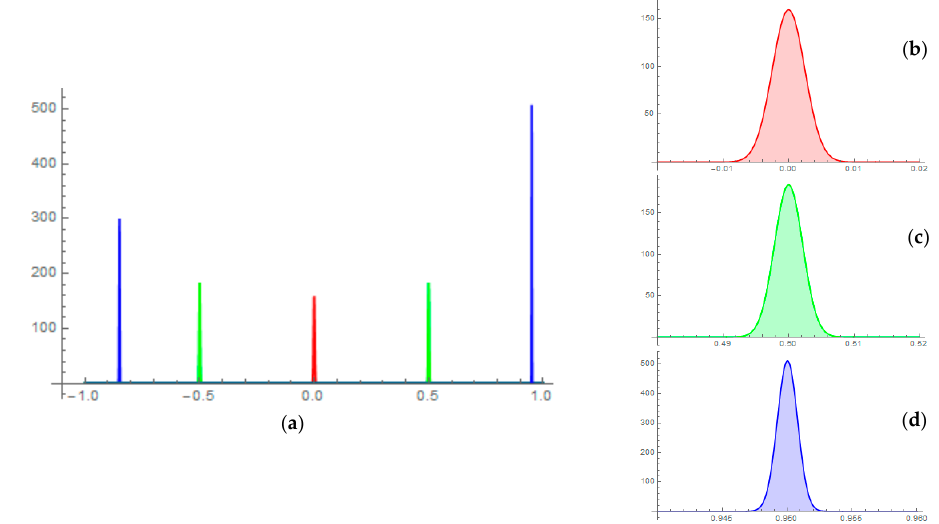
Figure 2. Specimen ˆ ρ sampling distributions for a 400-by-400 image. ( a ) across the range of ρ values, [ − 1, 1]; ( b ) zoom-in of the ρ = 0 sampling distribution; ( c ) zoom-in of the ρ = 0.5 sampling distribution; and ( d ) zoom-in of the ρ = 0.95 sampling distribution.